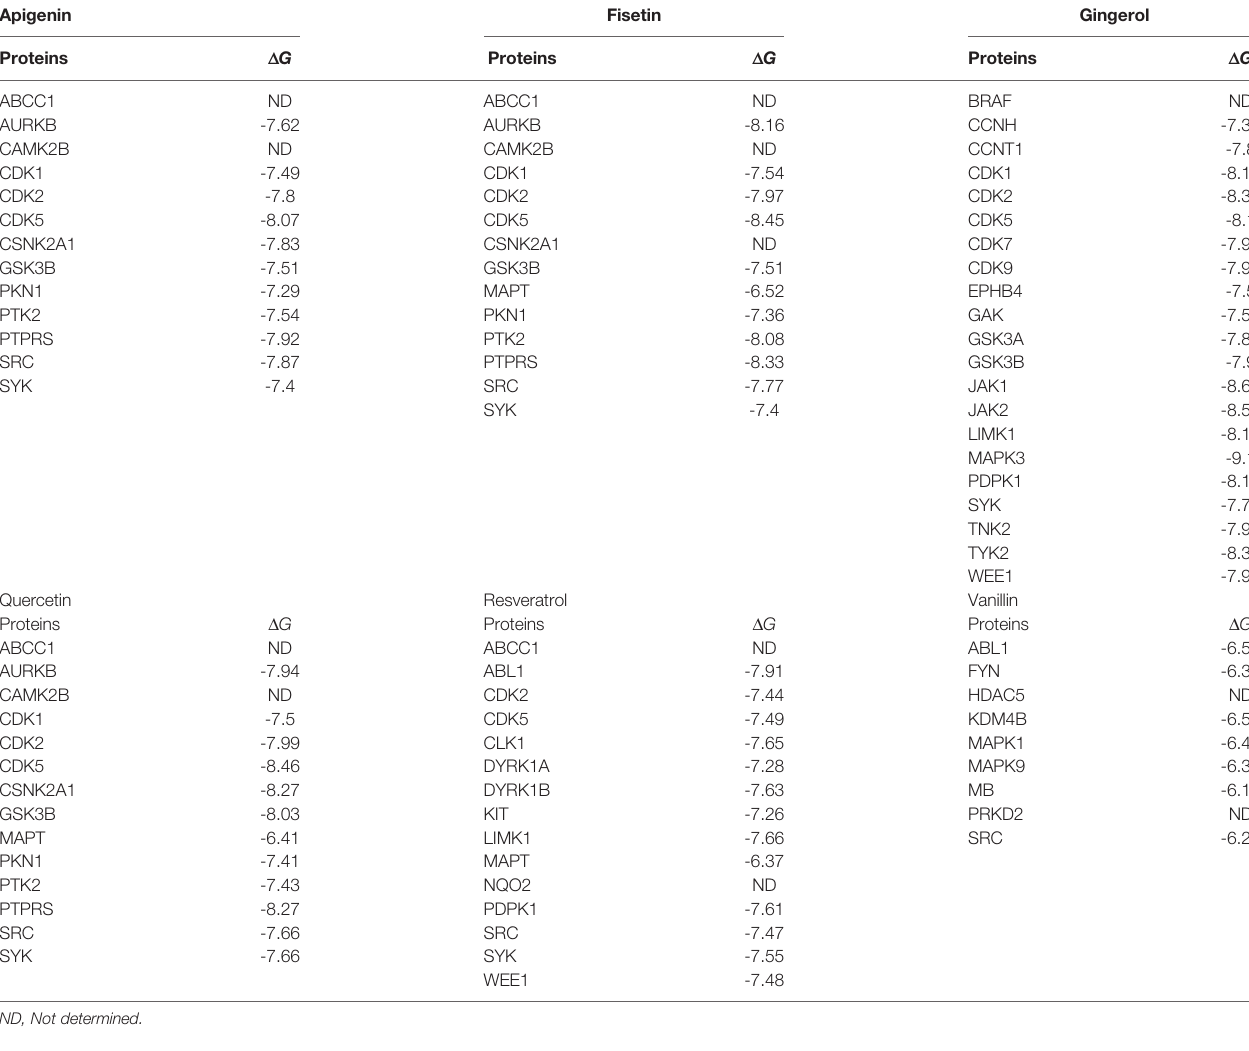
TABLE 2 | Docking of the MARK4 interactors proteins and the respective interactors (small molecule inhibitors).